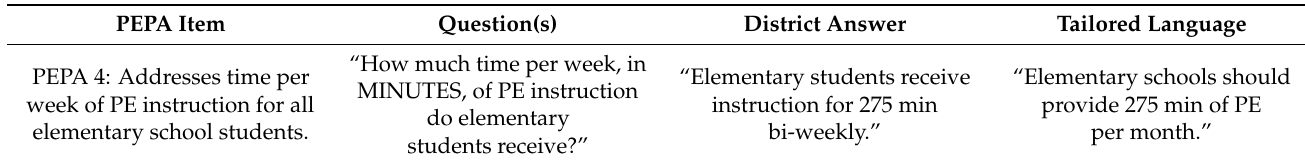
Table 2. Alignment and enhancement of pilot district PEPA